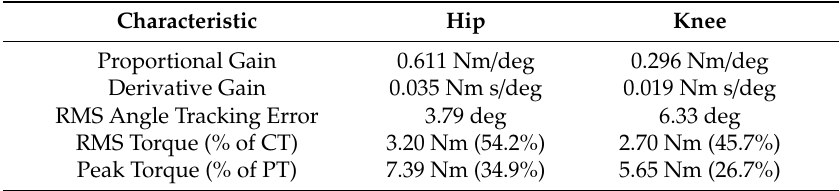
Table 5. Controller gains and summary of experimental